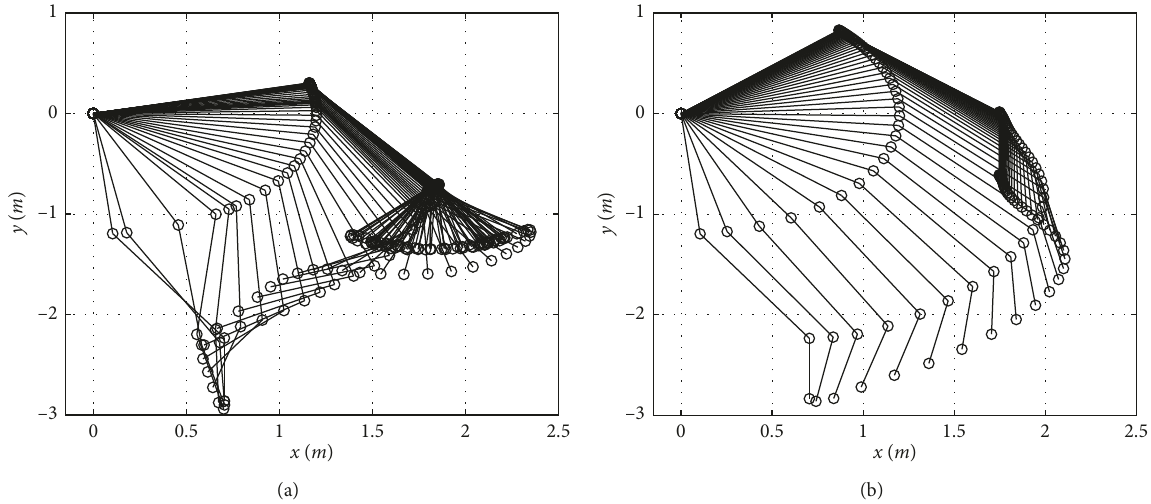
Figure 15: Robot displacement trajectory (5(s)). Robot displacement trajectory by control (a) without MR and (b) with MR.